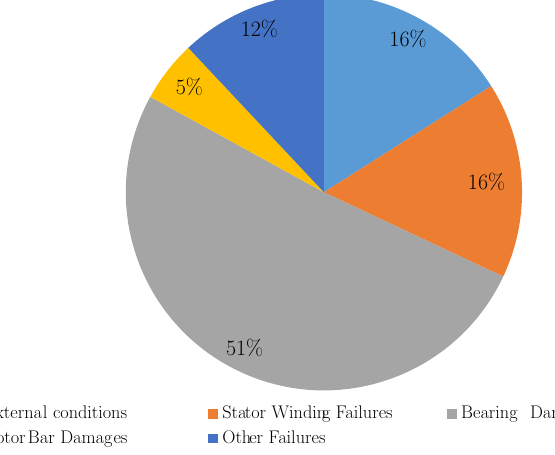
Figure 2. Pie chart for common reasons for downtimes of